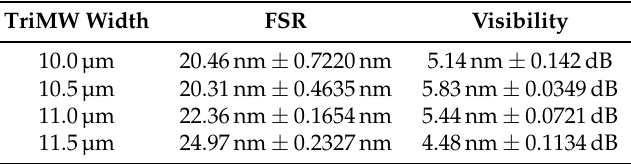
Table 1. FSR and visibility detailed data.